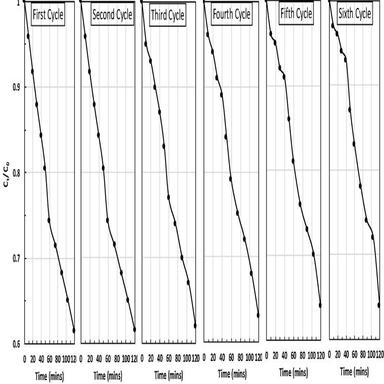
Repeated cycle of photocatalytic operations using the Au0 (NPs)/TiO2(T) nanocomposite thin film for the degradation of Alizarin Yellow (: 5.0 mg/L; pH: 6.0).